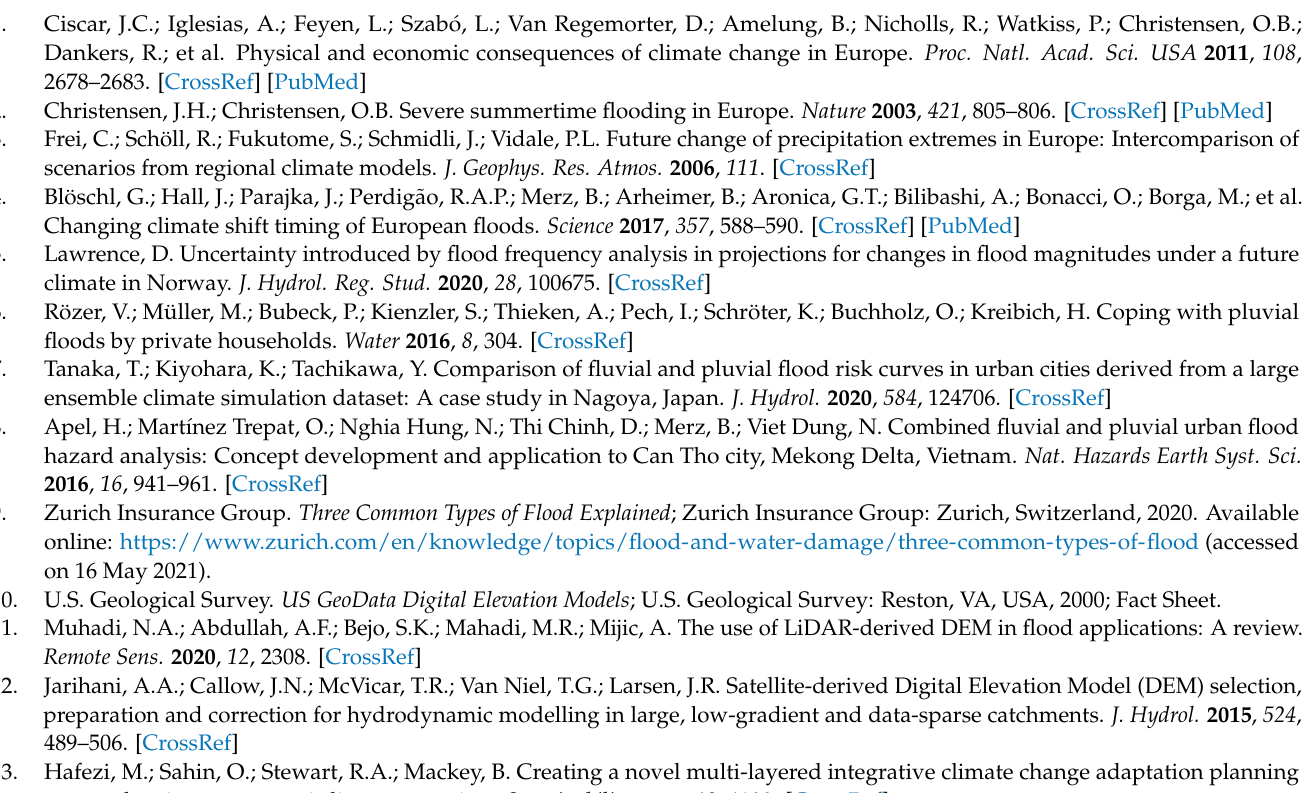
Figure A1. Flow diagram of the main steps of the methodology.